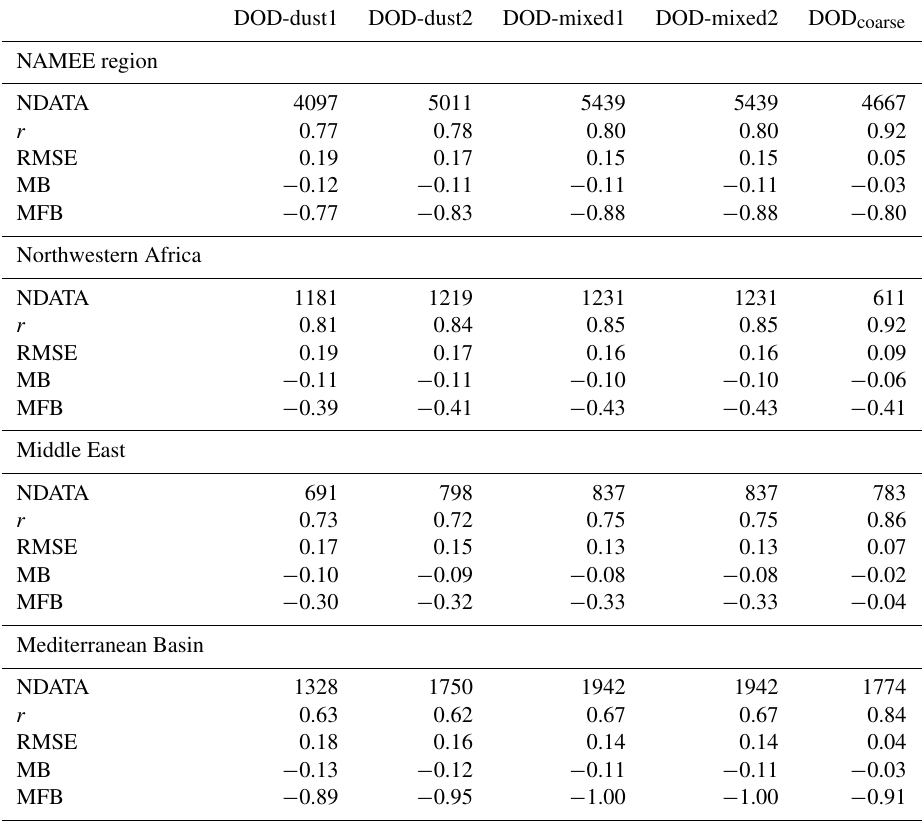
Table 9. Same as Table 7 but using monthly reanalysis values and AERONET dust-filtered AOD and AOD coarse averaged on a monthly basis as